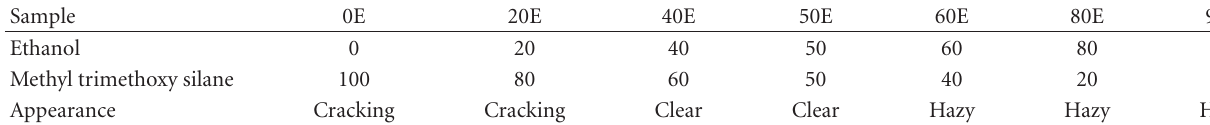
Table 2: The sol-gel formulation using ethanol as solvent.